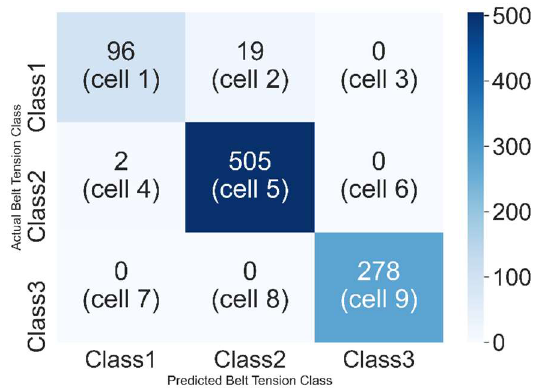
Figure 15. Confusion matrix of FASTory belt tension class predictor ANN model.